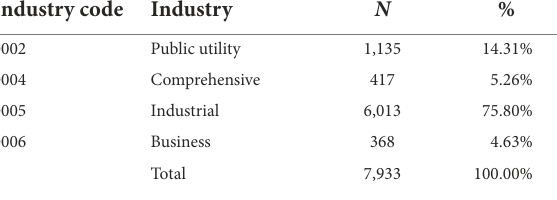
TABLE 3 Sample distribution across